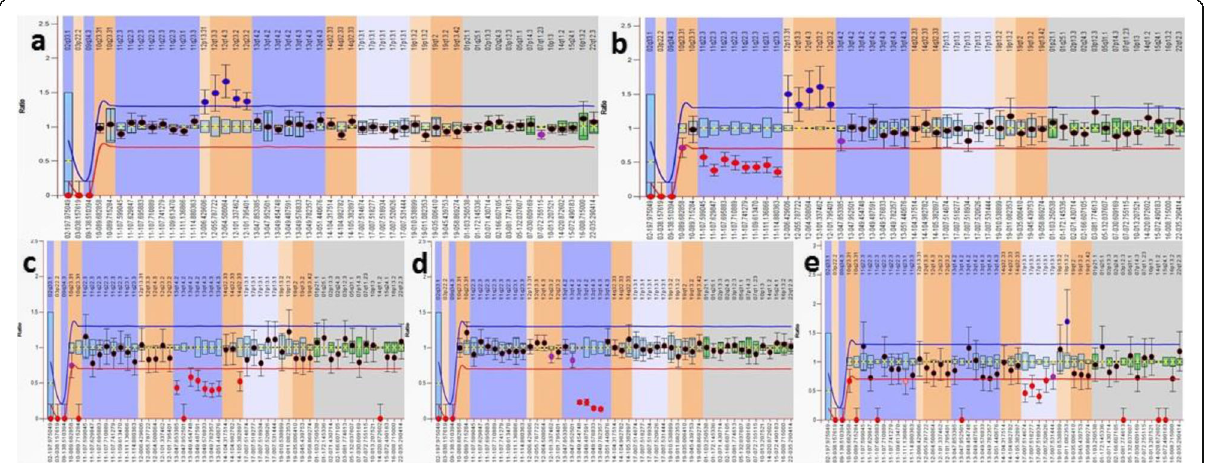
Fig. 2 Ratio charts of MLPA results for some CLL patients using SALSA MLPA probemix P038-B1 CLL. Probe ratios below 0.7 (bottom line) or above 1.3 (top line) are usually regarded as indicative of a deletion or duplication, respectively. a is a patient having trisomy 12, b is a patient having 11q deletion and trisomy 12, c is a patient having 13q deletion, d is a patient having 13q deletion (this patient is having 30% mosaic 13q deletion by FISH), and e is a patient having 17p